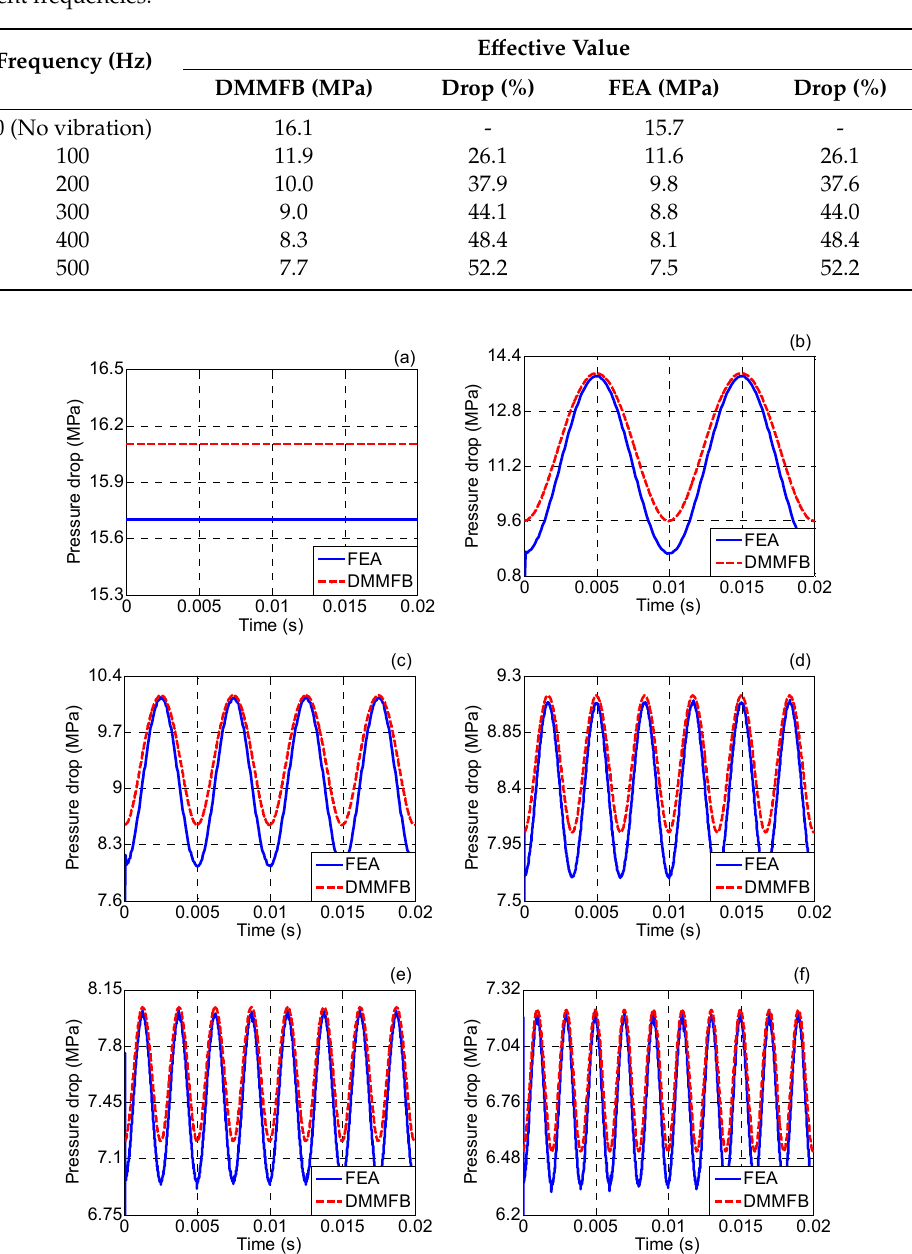
Figure 6. The internal pressure drop of the extrusion liquefier without and with 0.35 g vibration applied at different frequencies. ( a ) No vibration applied, ( b ) 100 Hz, ( c ) 200 Hz, ( d ) 300 Hz, ( e ) 400 Hz, ( f ) 500 Hz.